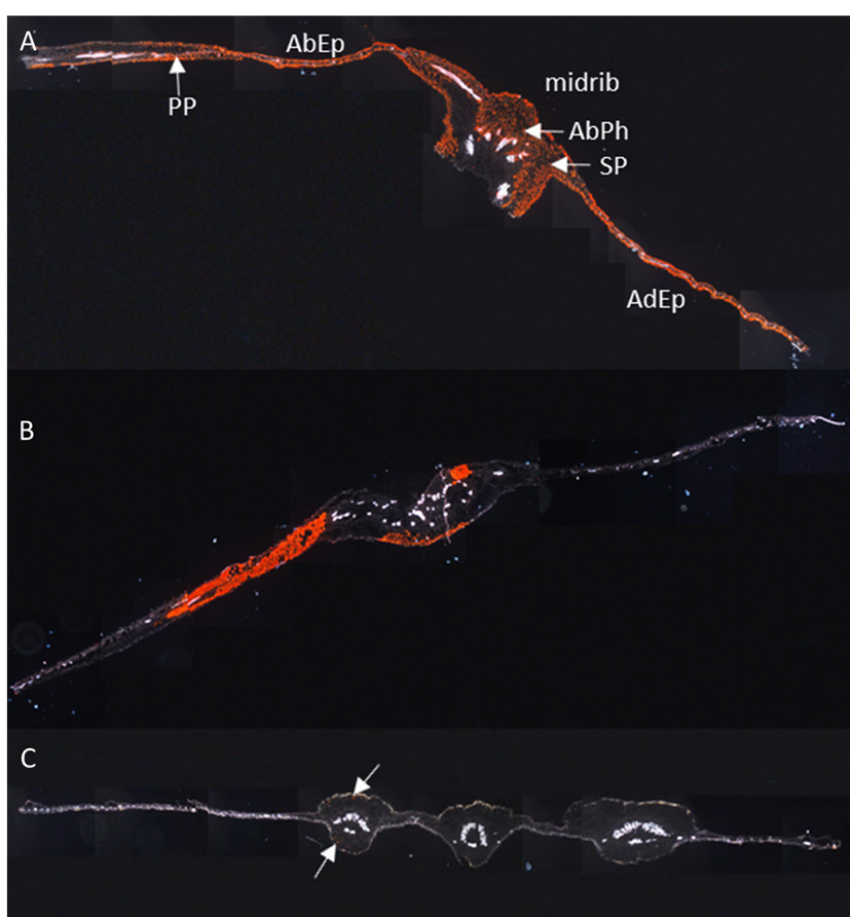
Figure 6. Distribution of CBSV-Mo83 RNA in cassava leaf sections. Panorama pictures were com- posed of cross sections from leaf tissues subjected to RNAscope ® ISH using a CBSV-Mo83 probe. Red dot signals indicate the presence of viral RNA in phloem cells and non-phloem cells of the cassava variety ( A ) Albert, ( B ) Namikonga and ( C ) DSC 167, the latter showing signal only in few cortical collenchyma cells (white arrows). PP, palisade parenchyma; SP, spongy parenchyma; AdEp, adaxial epidermis; AbEp, abaxial epidermis; AbPh, abaxial phloem; AdPh, adaxial phloem.